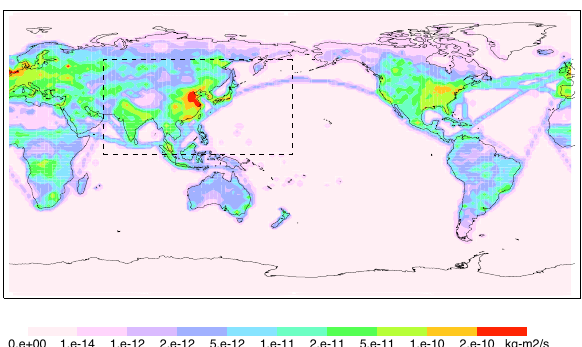
Fig. 9. NO surface emissions for July. Black dashed line shows re- gion of tagged or perturbed emissions.